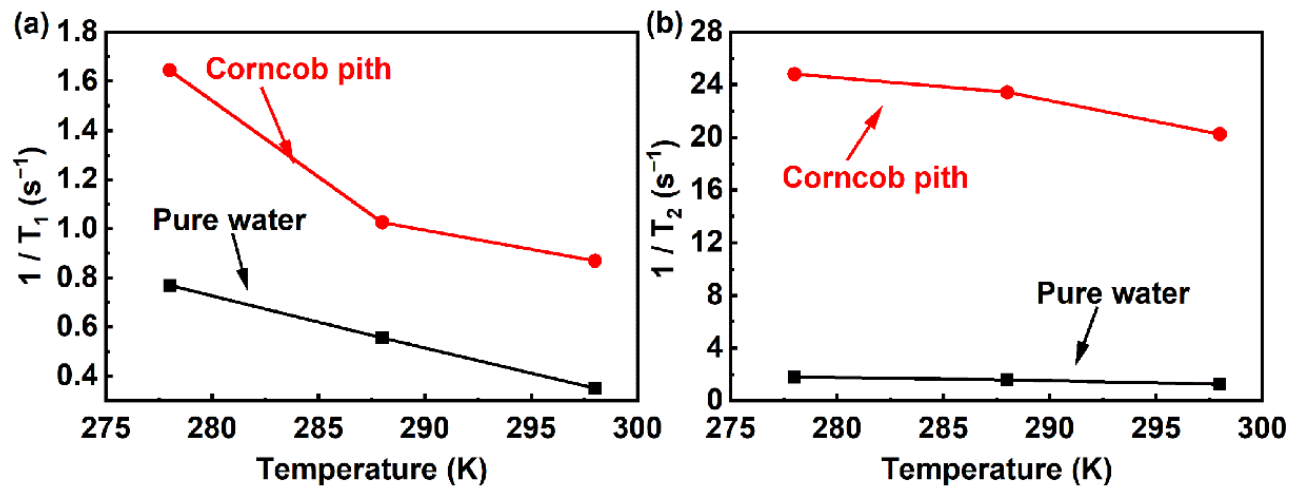
Figure 7. ( a ) 1 H-1/T 1 values and ( b ) 1 H-1/T 2 of confined water in corncob pith at different tempera- tures by using 600 MHz NMR measurements.